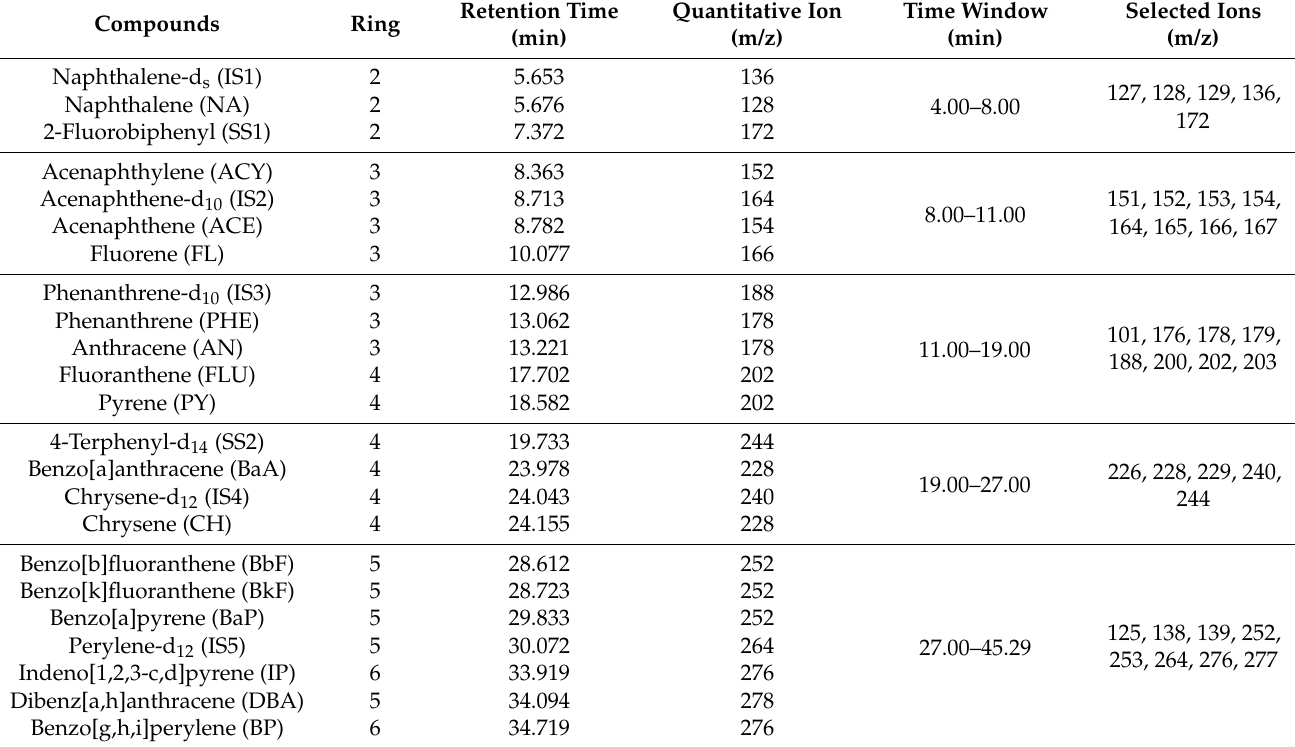
Table 2. Selected ion monitoring of individual PAH in the GC/MS